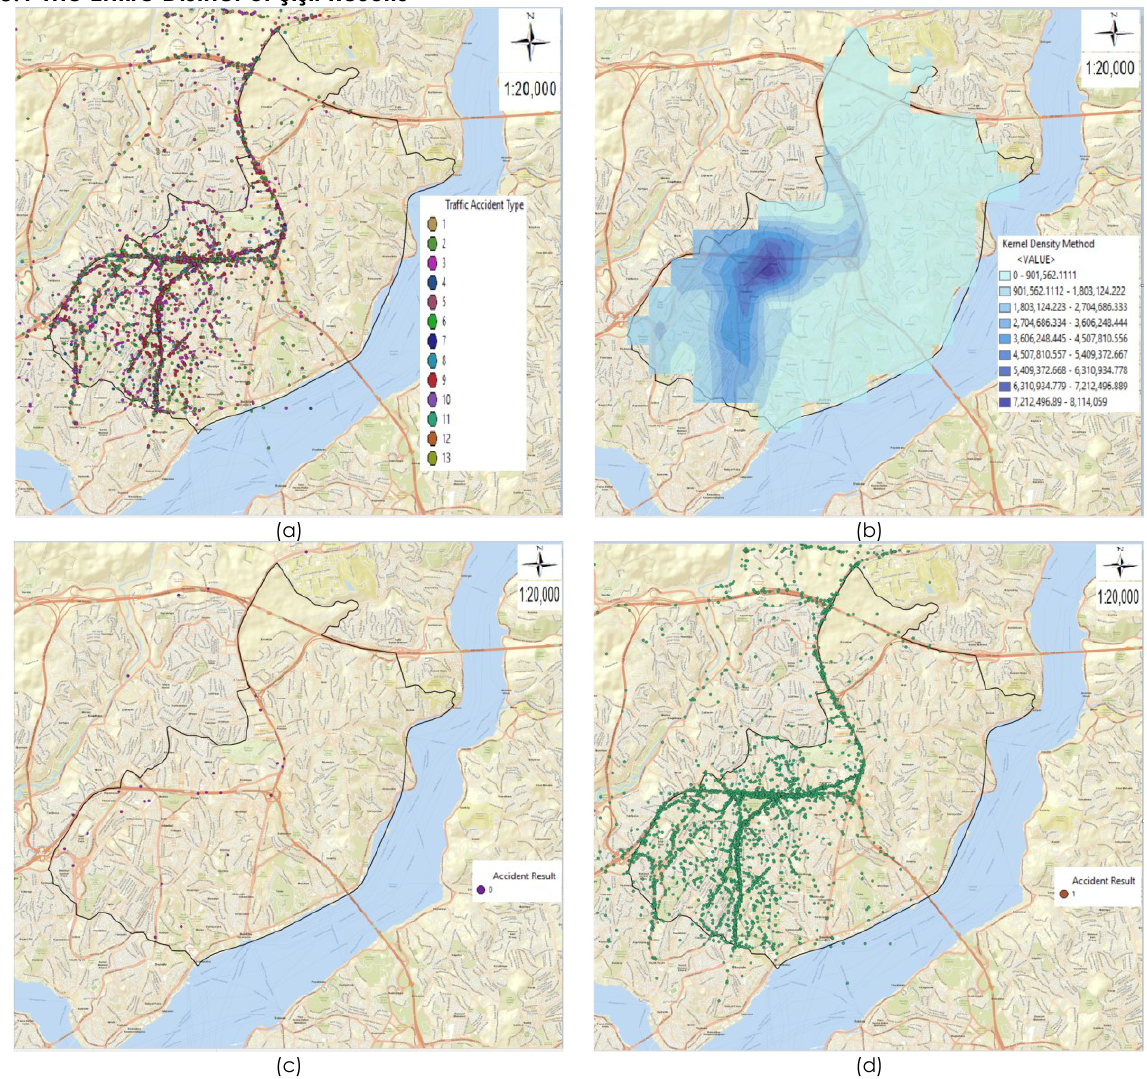
Figure 1. Maps of traffic accidents in Şişli district: (a) Thematic accident map by type of accident; (b) Kernel Density method map; (c) Thematic accident map of fatal accidents; (d) Thematic accident map of injury